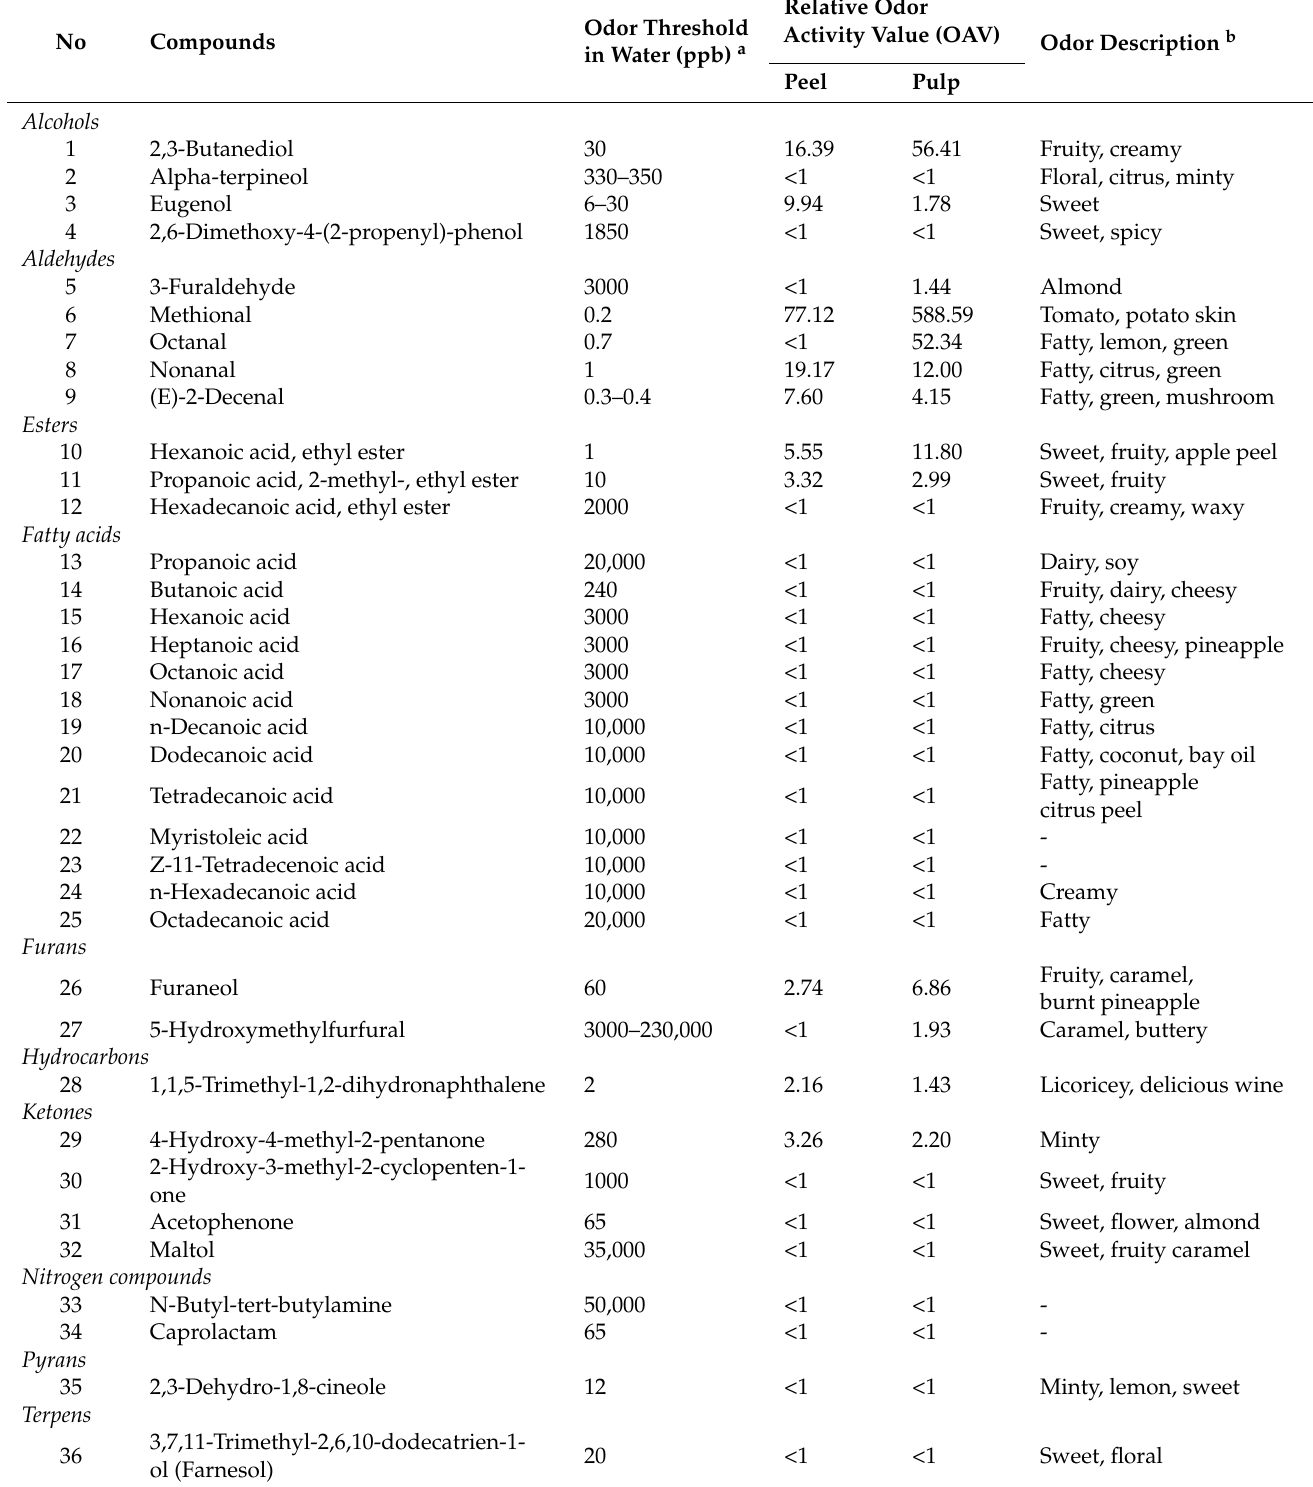
Table 3. Odor threshold in water, relative odor activity value (OAV), and odor description of selected volatile compounds identified in peel and pulp of